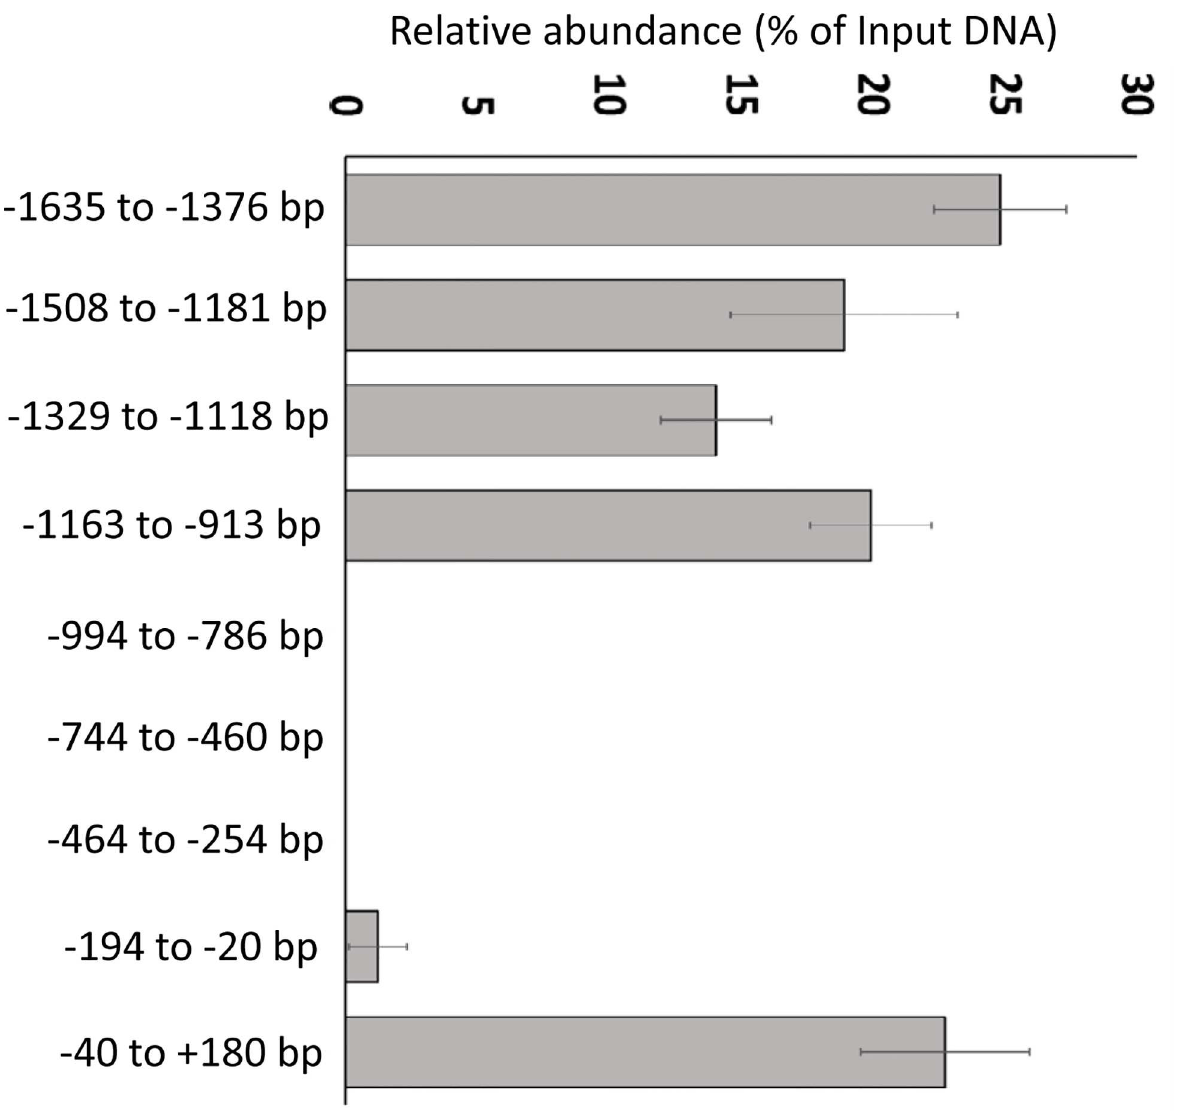
Fig 6. Nuclear Act1 binds to the DEFB4 promoter regions. HBE1 cells were transfected with Act1-FLAG and fixed 24h post- transfection. Isolated nuclei were sonicatedand chromatin immunoprecipitation (chIP) was performed using an anti-FLAG antibody or non-specific mouse IgG. PCR was used to detect DEFB4 promoters in the immunoprecipitated material. The data was presented as % of the input as describedin Materials and